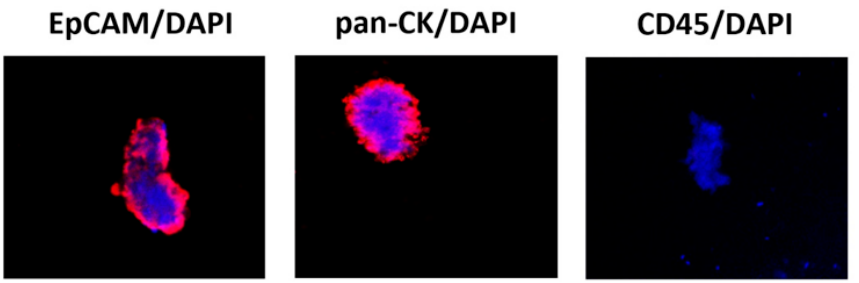
Figure 1. Confocal microscopy representative images of isolated CTCs stained for epithelial and hematopoietic markers. Representative image by confocal microscopy of circulating cancer cells stained with anti-human EPCAM, anti-human pan-CK or anti-human CD45 Abs followed by goat anti-mouse secondary antibody Alexa 594-conjugated. DAPI was used to counteract nuclei. Magnification 100×. CK = cytokeratin, an epithelial cytoplasmic marker; DAPI = nuclear marker; EpCAM = epithelial membrane marker; CD45 = leukocyte common antigen.